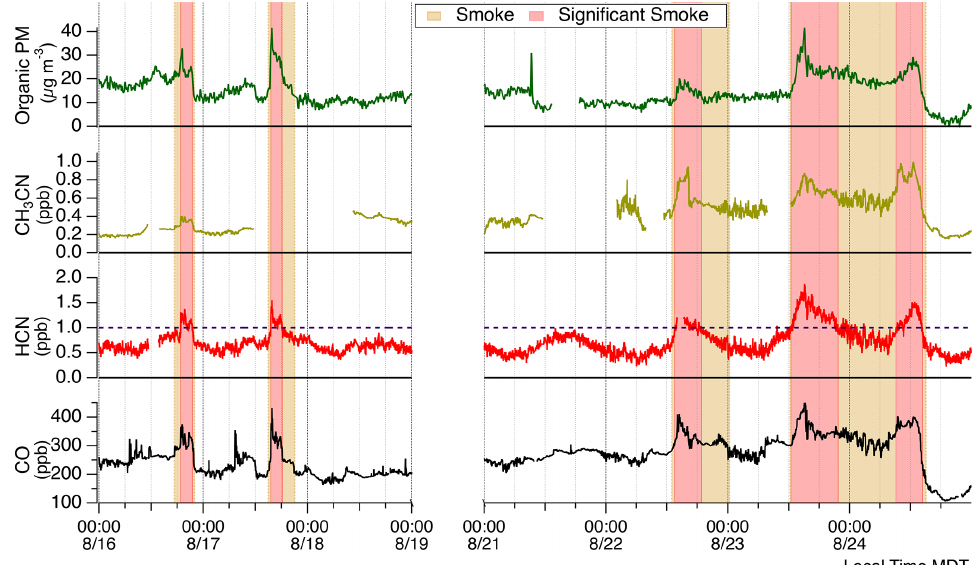
Figure 2. Time series of smoke tracers. Tan shading represents smoke presence, while red shading signifies significant smoke periods. Significant smoke periods are defined by HCN concentrations greater than 1ppbv. This smoke-defining concentration is indicated by the dashed purple line.